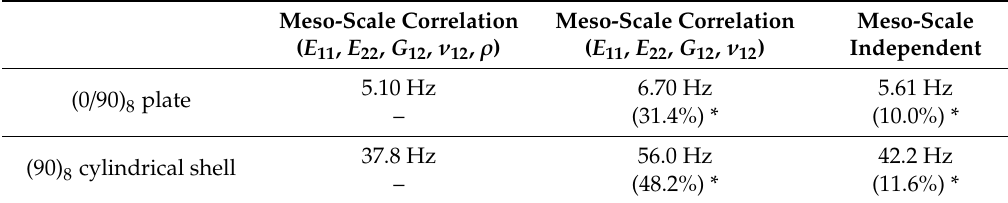
Table 5. Standard deviation of first order natural frequency considering di ff erent